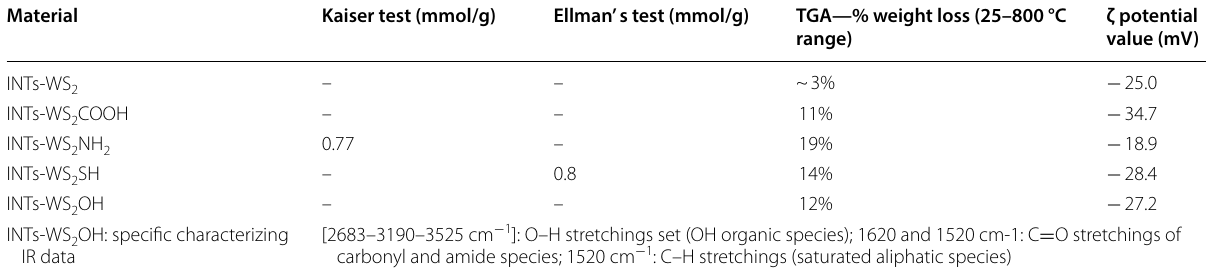
INTs, inorganic nanotubes; TGA, thermogravimetric analysis—starting INTs-WS 2 nanotubes are negatively charged ( arising from industrial nanofabrication step